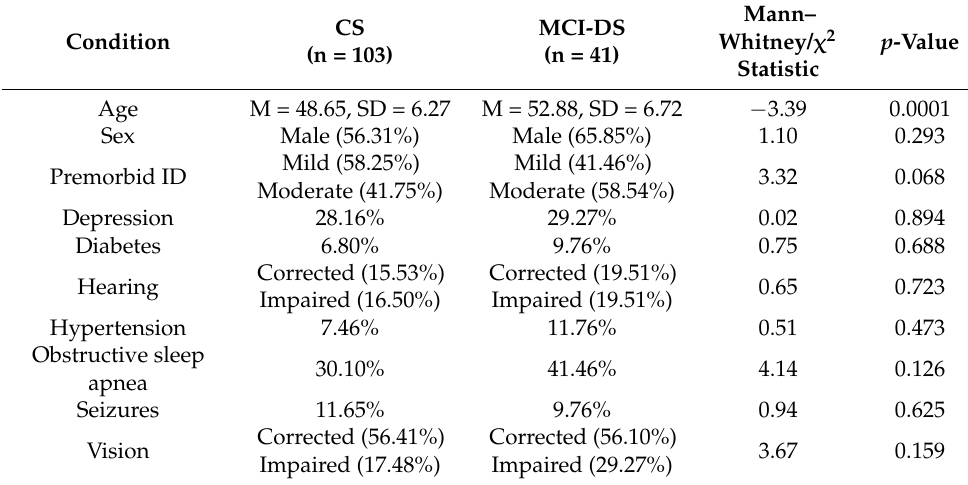
Table 1. Demographic and health comorbidities by AD